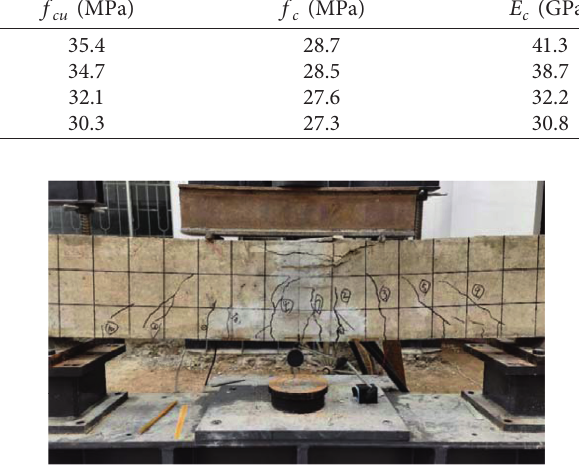
Figure 4: Failure state of the test